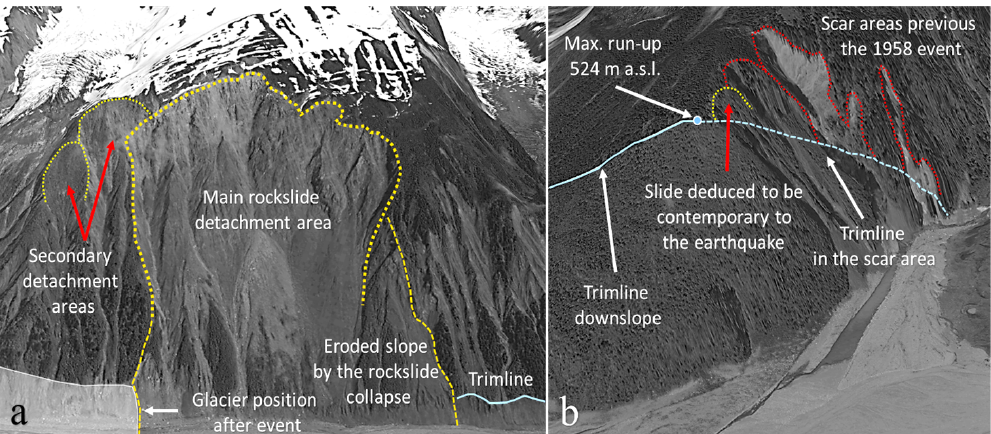
Figure 2. Rockslide source and opposite-facing slope of the maximum run-up (info according from the interpretation of Ward and Day, 2010; see Fig. 1). (a) Northeast-directed overview of rockslide detachment area. (b) Northwest-directed overview towards Gilbert Inlet: the blue line shows the tsunami trimline on Gilbert Head as mapped by Miller (1960), dotted red lines are related to pre-1958 event scar areas on this slope, and dotted yellow lines are related to a slide that is supposed to be coincident with the earthquake of 9 July 1958 as interpreted by Miller (1960) (topography data from © Google Earth Pro 7.3.2.5776; last access: 24 April